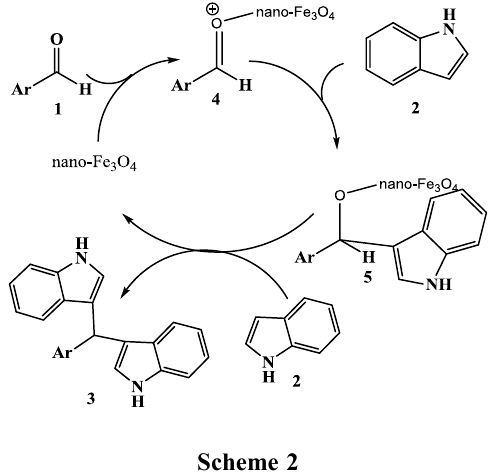
O in the synthesis of 3 4